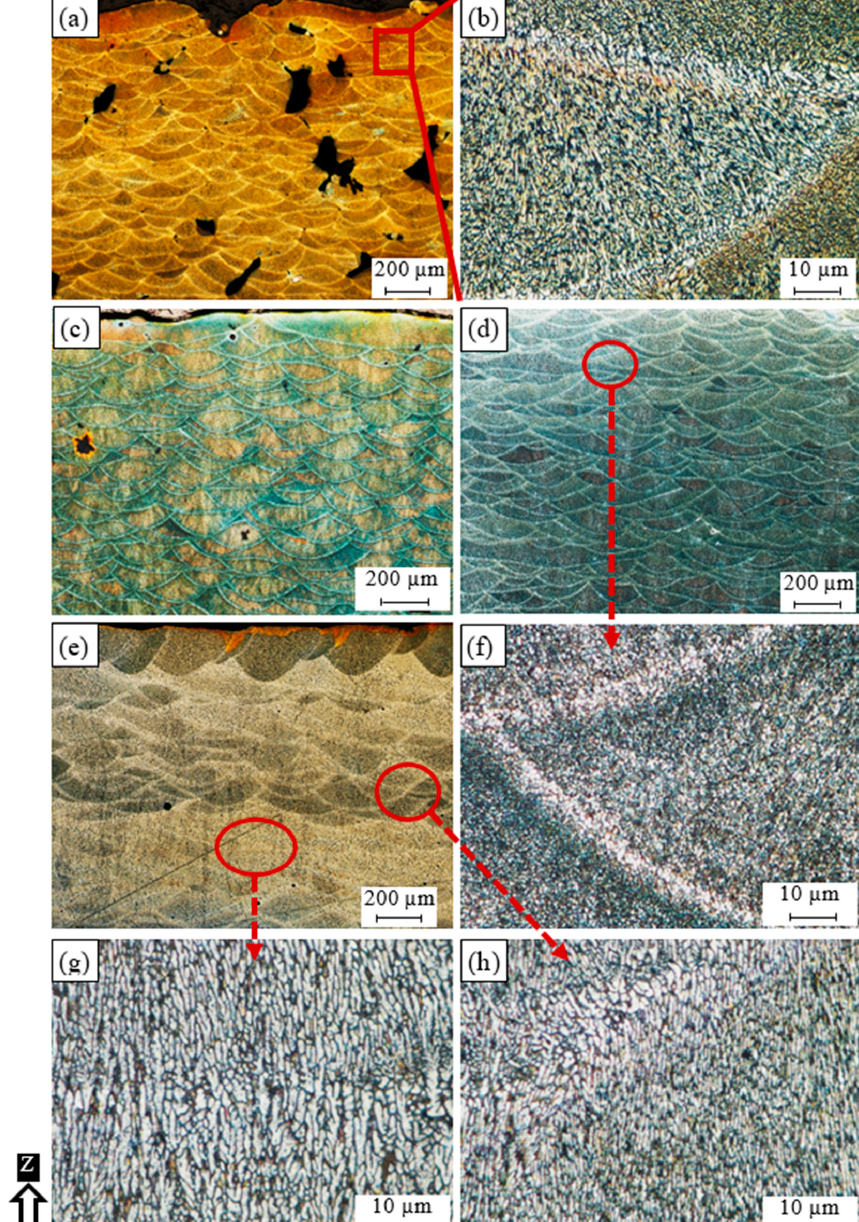
Figure 1. Microstructure of the as-built AlSi10Mg_200C samples processed under different SLM process parameters; ( a,c ) AS8; ( b ) AS7; ( d,f ) AS3, and ( e,g,h ) AS1.